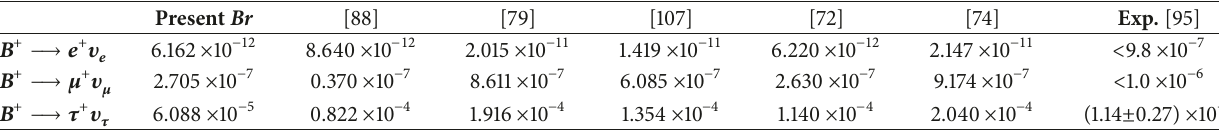
Table 12: Leptonic branching ratio of B + meson.